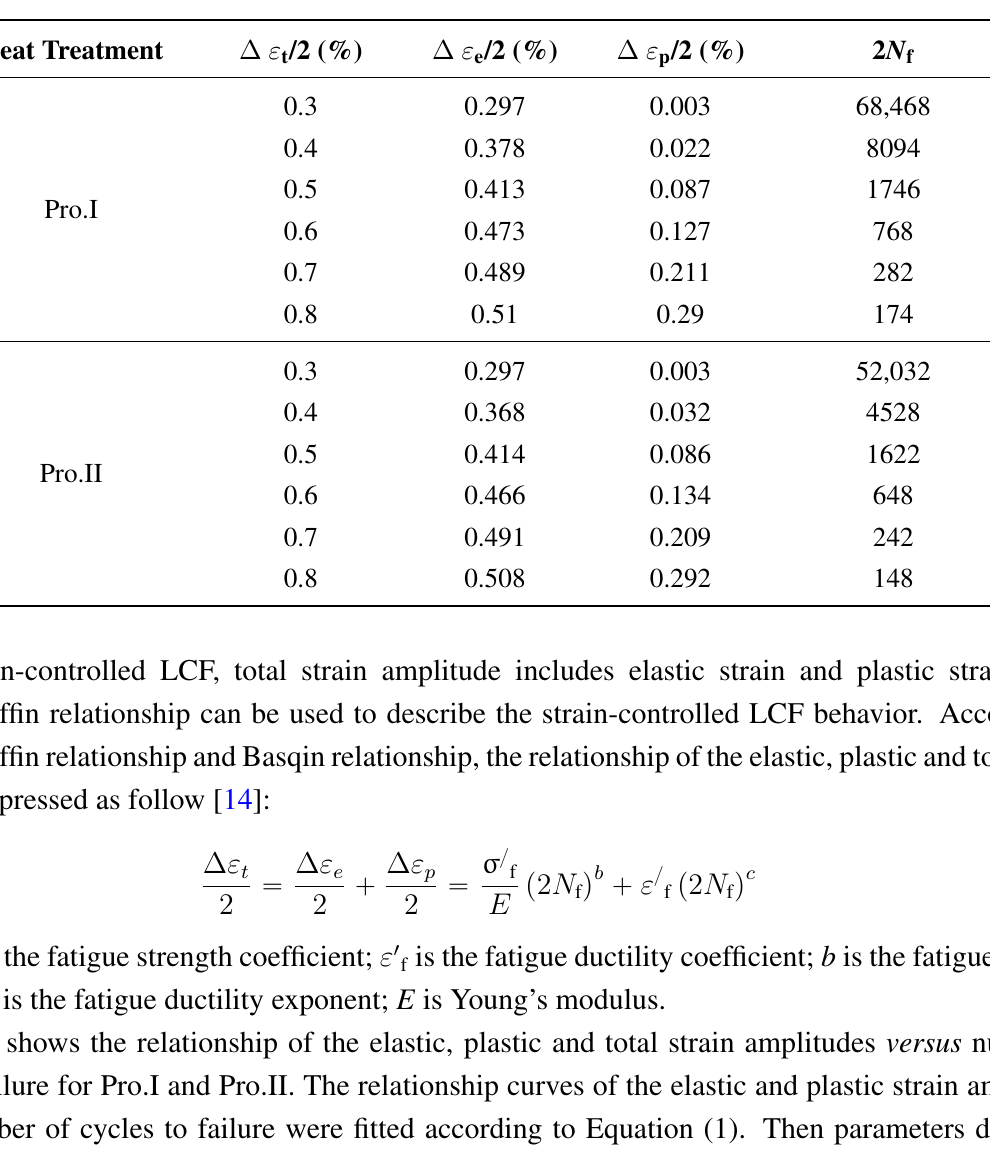
Table 1. Fatigue test results under different heat treatment